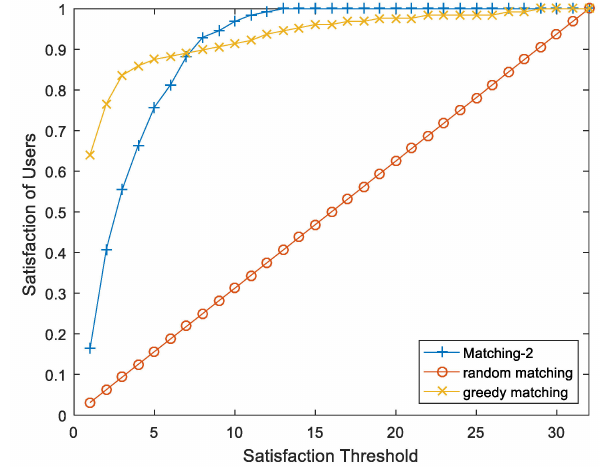
Figure 2. Users’ satisfactions versus satisfaction threshold ( n = 32, K = 4, J =